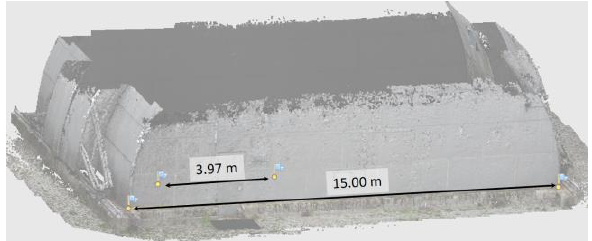
Figure 5 . Building used for calibration tests.